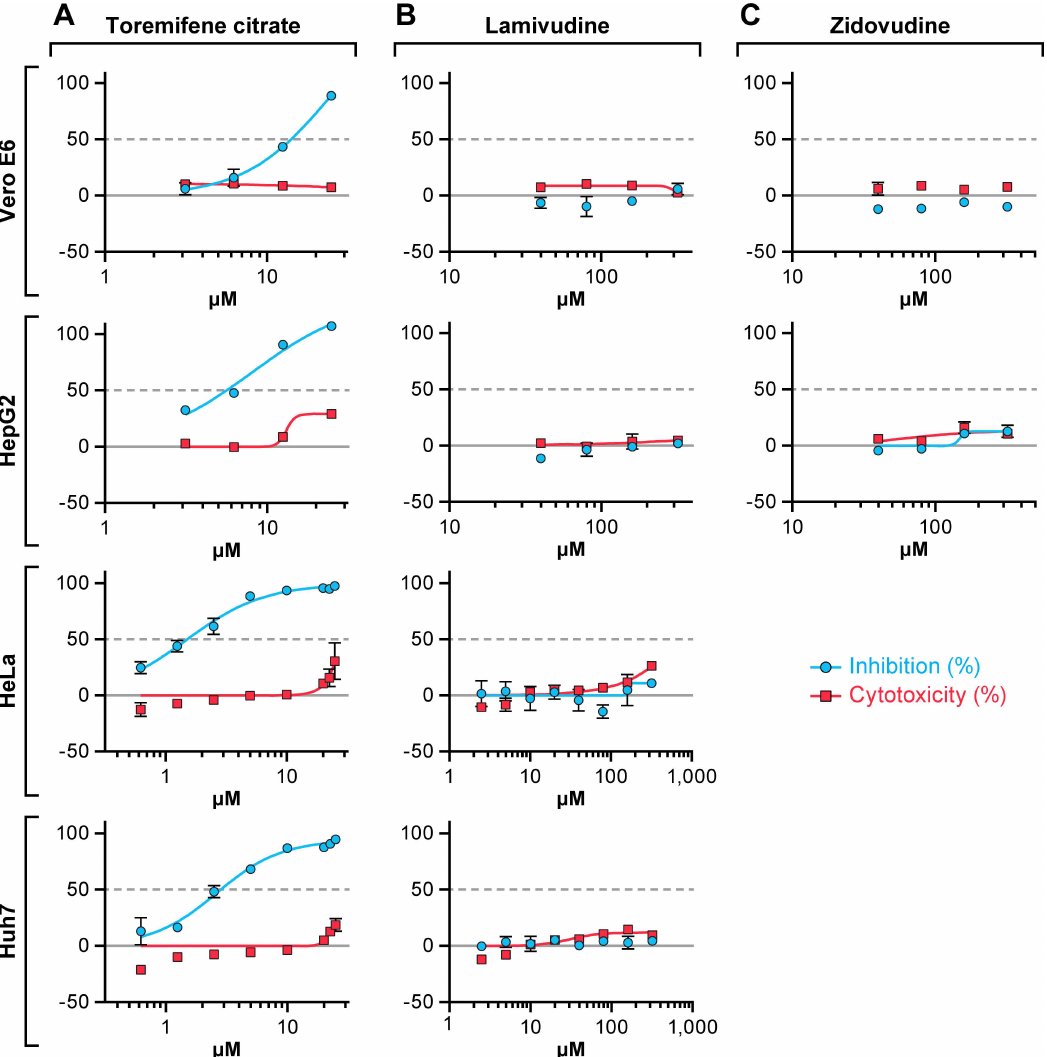
Fig 1. Antiviral activity against Kikwit variant of Ebola virus. Vero E6, Hep G2, HeLa, or Huh 7 cells were treated 1 h with toremifene citrate (A), lamivudine (B), or zidovudine (C). Two-fold dilutionsof the drugs were tested in a 4- to 8-point dose-responsecurve. Then cells were infected at a multiplicityof infection(MOI) of 1 for 48 h. Toremifene citrate was used as a positive control. Antiviral activity is shown in blue and cytotoxicity is shownin red. The experiment was run on duplicateplates with triplicate wells per dose (mean ± SD; n = 3). Representative graphs from 1 to 4 independent experiments are